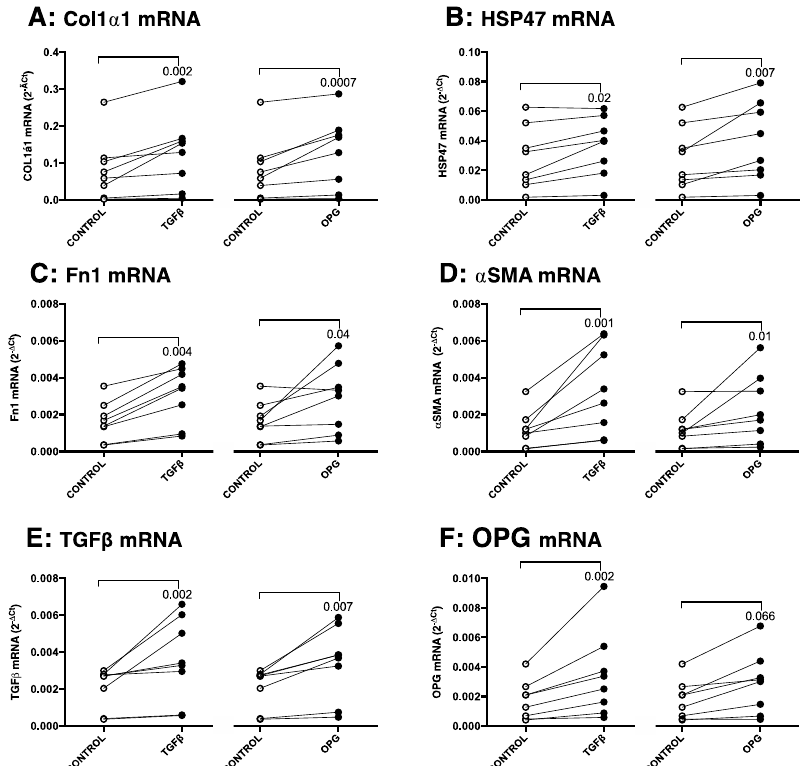
Figure 5. OPG treatment of liver slices results in higher expression of fibrosis-associated markers. Treatment of mouse precision-cut liver slices with 10 ng / mL OPG resulted in higher mRNA expressions of fibrosis-associated markers Col1 α 1 ( A ), HSP47 ( B ), Fn1 ( C ), α SMA ( D ), and TGF β 1( E ) just like treatment with positive control TGF β 1. OPG itself was only significantly upregulated by TGF β 1 treatment and not significantly after OPG treatment ( F ). Groups were compared using a Friedman test with a Dunn’s correction for multiple testing and p < 0.05 was considered significant.